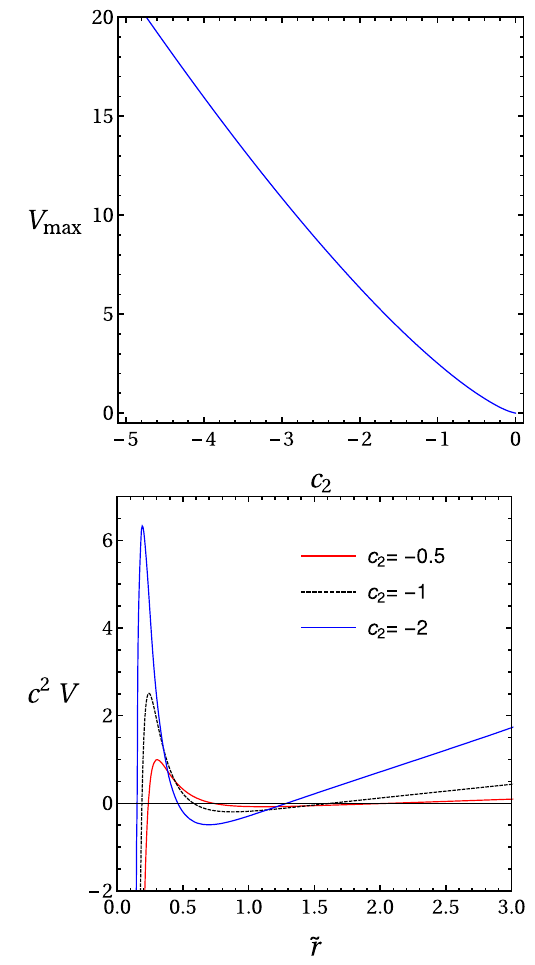
Fig. 5 The left panel shows the maximum dRGT potential with (cid:18) = 0, ˜ M = 0.1, α β g = 0.1, c = 1, and m = 0.565375. The right panel shows the dRGT potential with (cid:18) = 0, ˜ M = 0.1, α g = 0.1, c = 1, and β m =